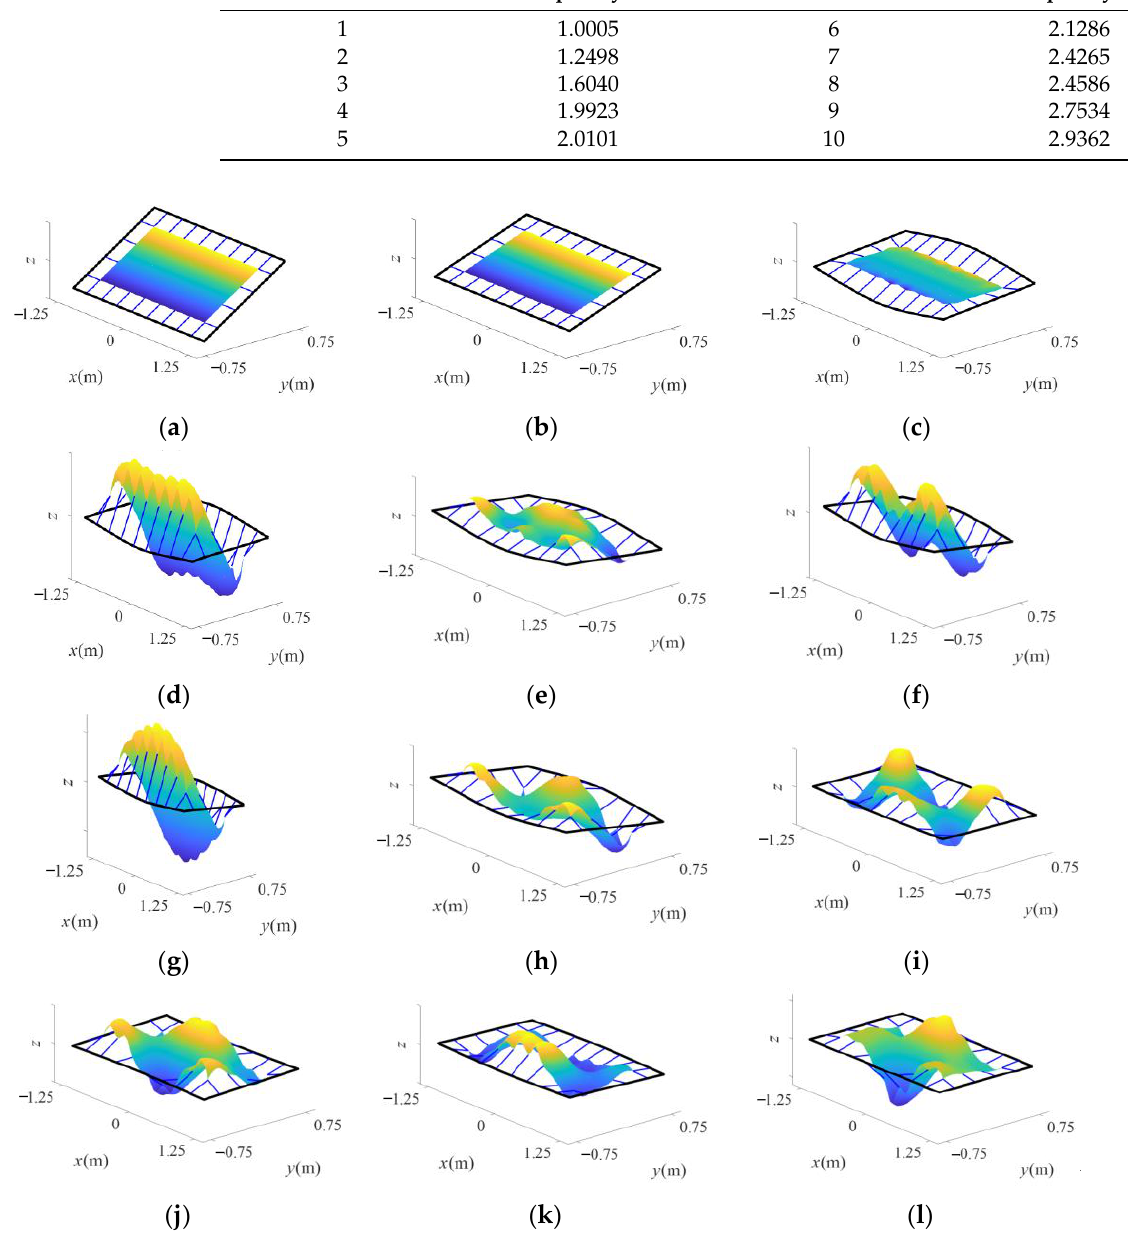
Figure 4. Shape response of the membrane antenna ( ω 0 = π /5 rad/s; T = 1 s; α = β =0.01). ( a ) Uniform rotation, ( b ) start to decelerate: t = 0 s ( c ) t = 0.04 s ( d ) t = 0.15 s ( e ) t = 0.5 s ( f ) t = 0.6 s ( g ) t = 0.8 s ( h ) t = 1 s ( i ) t = 1.2 s ( j ) t = 1.4 s ( k ) t = 1.55 s ( l ) t = 1.85 s.